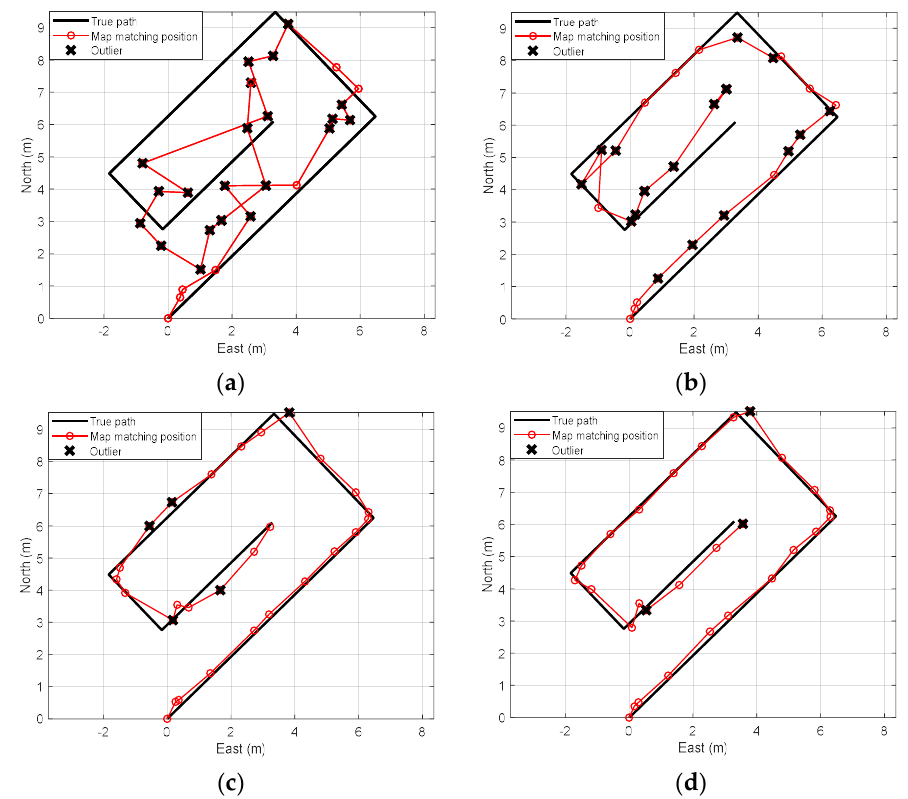
Figure 9. Comparison of map-matching results based on true path. ( a ) Foot-mounted single sensor case, ( b ) waist-mounted single sensor case, ( c ) multiple sensors without outlier mitigation, and ( d ) multiple sensors with outlier mitigation.